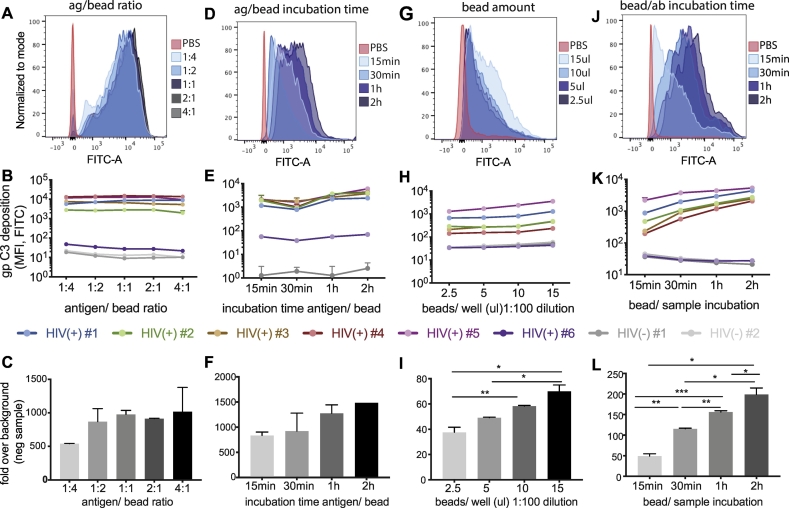
Optimization of the bead coupling step and formation of immune complexes. The step of coupling of beads and antigen was optimized by testing 4–5 different conditions each for the ratio of antigen to beads, incubation time of antigen and beads, the amount of beads added per well, and the antibody sample incubation time. Six HIV-positive samples and two HIV-negative samples were tested at a 1:10 dilution for all of the optimization experiments. The histograms show results for the HIV positive sample #2 under the different conditions and the PBS control. Bar graphs indicate mean ± SD of technical duplicates. A–C: Different antigen to bead ratios from 1:4 to 4:1 were tested. D-F: Beads and biotinylated antigen were co-incubated for different time spans: 15 min, 30 min, 1 h and 2 h at 37 °C. G–I: The amount of beads per well was optimized by adding different volumes of the 1:100 bead dilution after coupling and washing to each well. Either 2.5, 5, 10 or 15 μl of a 1:100 bead dilution were added per well. J–L: The incubation time of antigen-coupled beads with antibody sample to form immune complexes was varied from 15 min up to 2 h at 37 °C.